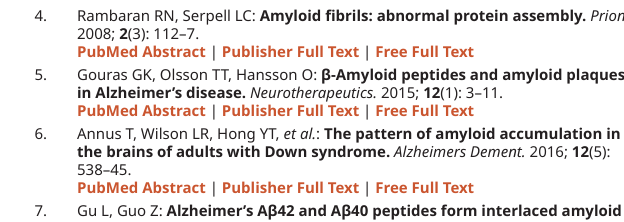
Figshare: Extended Data Workbook 4. GO Terms and Path- ways: Gene Ontology Biological Process terms and pathways associated with the AD-DS and Chr 21 genesets, https://doi.